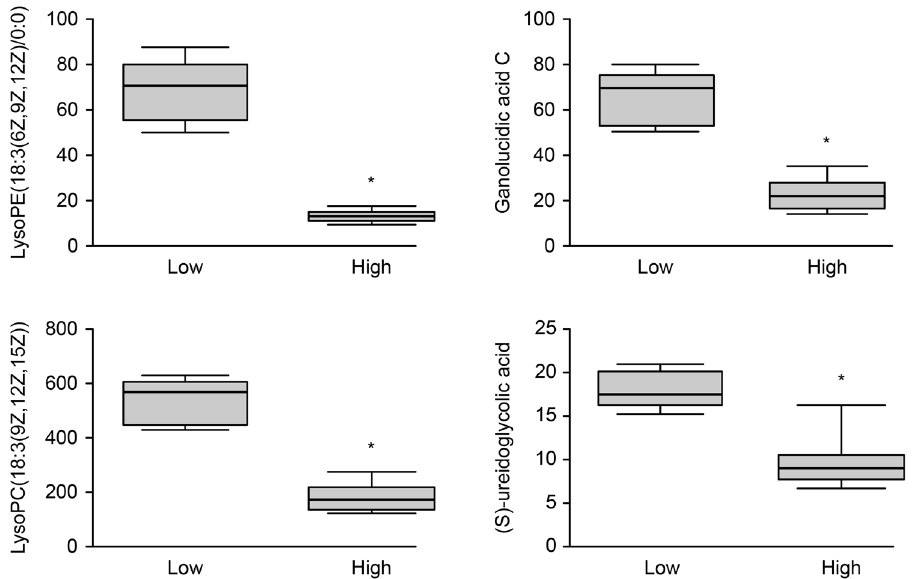
Figure 2. Metabolite profiles obtained from the quantitative analysis of the subjects. The figure was obtained using GraphPad Prism, and the names of metabolites are shown in the box plot. The box plot consists of the median (horizontal line) and the inter-quartile range, and the whiskers indicate the minimum and maximum values unless there were outliers, in which case the whiskers extend to a maximum of 1.5 times the inter-quartile range. The differences in LPC, ganolucidic acid C, LPE and (S)-ureidoglycolic acid between the LA and HA are displayed. “ * ” indicates P <